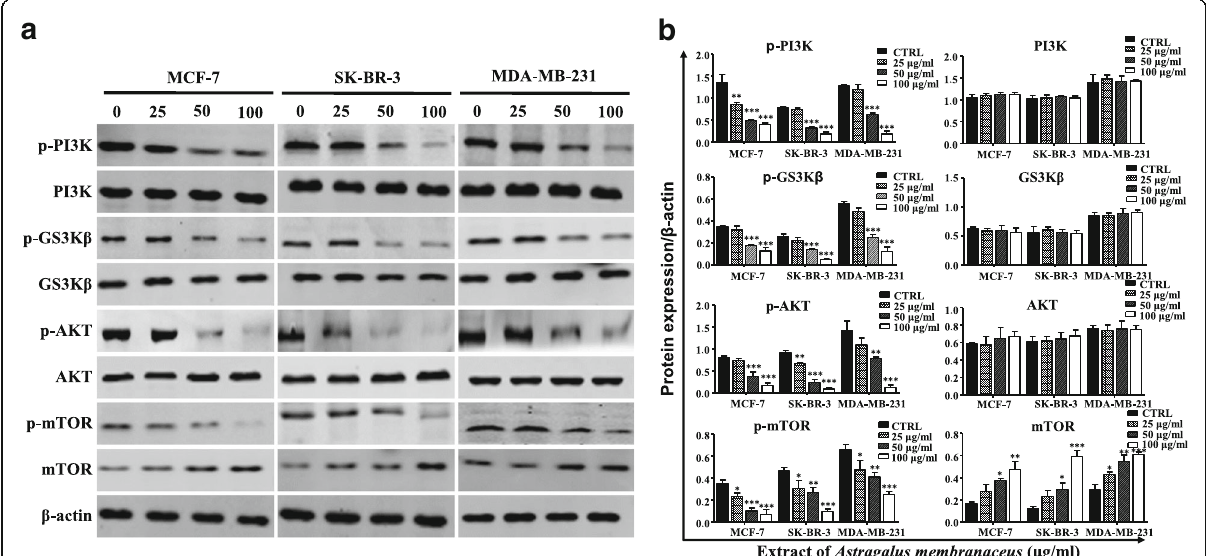
Fig. 5 Protein expressions of PI3K, GS3K β , Akt, mTOR, p-PI3K, p-GS3K β , p-Akt, and p-mTOR in breast cancer cells by western blot analysis. β -actin was used as a protein loading control. * p < 0.05, ** p < 0.01, *** p < 0.001, compared with blank control group (CTRL)